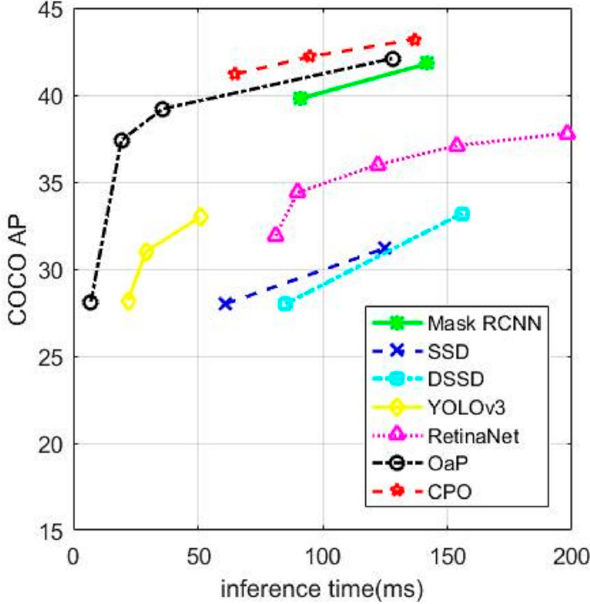
Figure 9. Speed-accuracy trade-off on COCO validation for real-time detectors (CPO outperforms many algorithms).